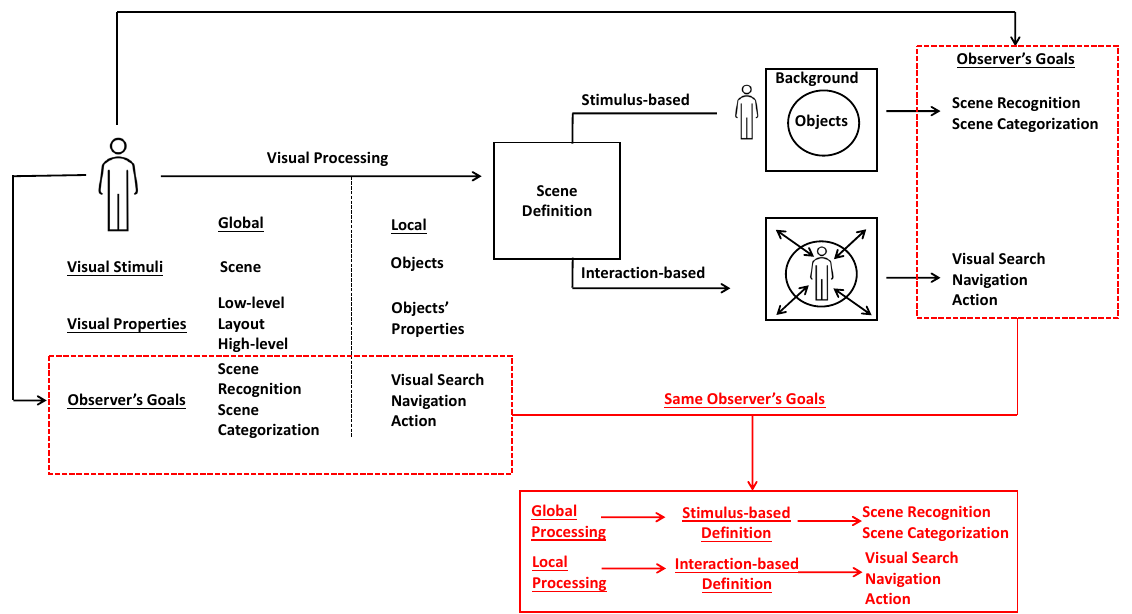
Figure 6. The relationship between visual processing, scene definitions, and observer’s goals.